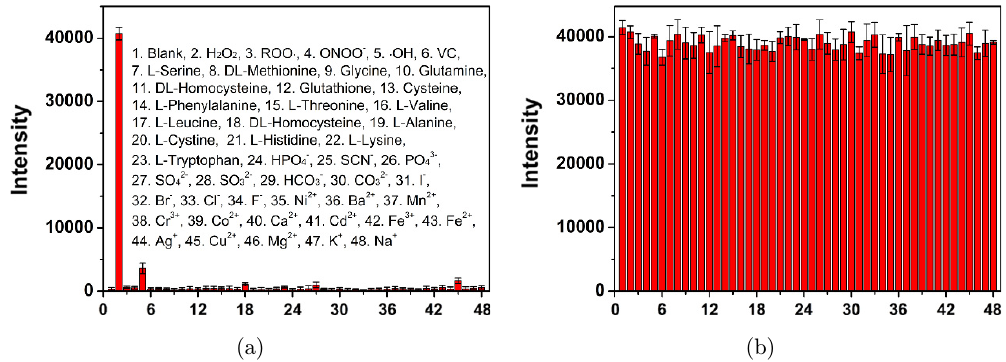
Fig. 2. (a) The °uorescence response of CBH in PBS bu®er solution to various analytes. (b) The e®ect of various analytes on the °uorescence response of CBH in PBS bu®er solution.